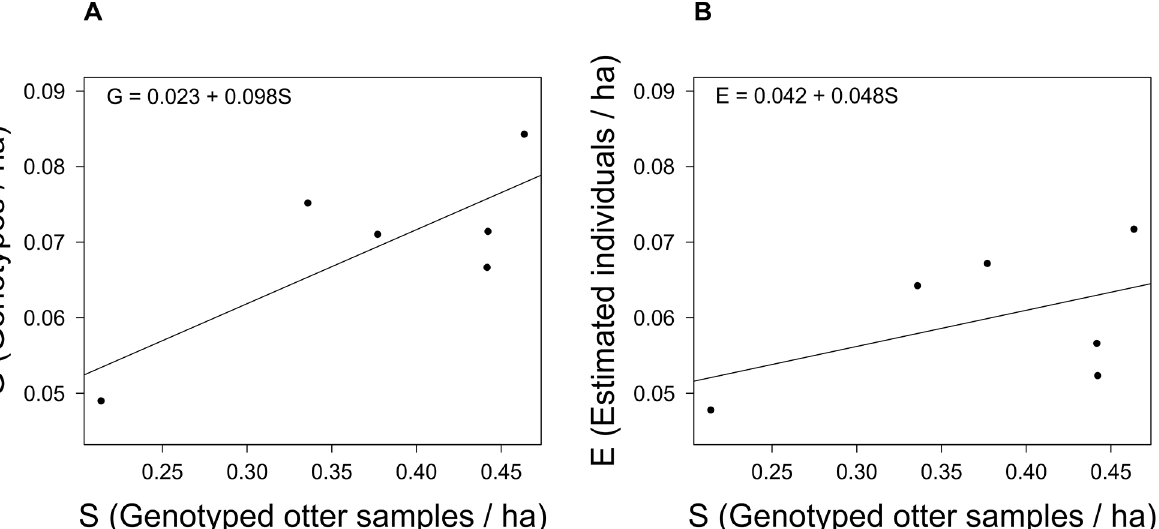
Fig 3. Relationship between spraint densities and otter numbers. Linear regressions between number of genotyped otter samples per ha (S) and (A) number of genotypes per ha (G) (R 2 = 0.62, df = 4, p = 0.063) and (B) number of estimated individuals (E) (R 2 = 0.24, df = 4, p = 0.33), respectively. Equations for both regressions are offered.